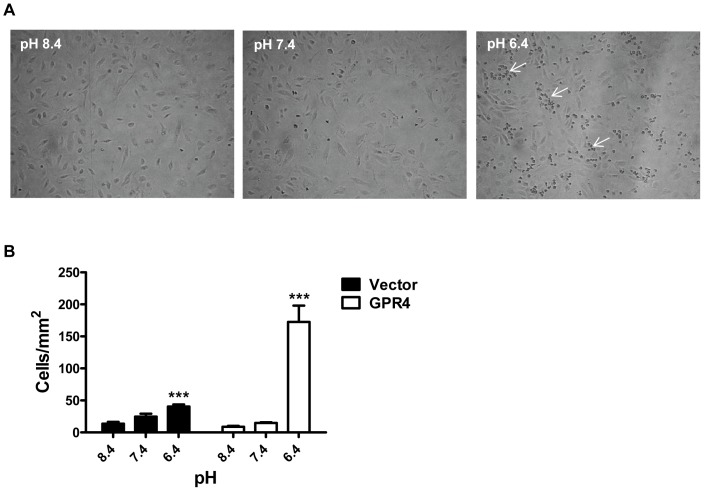
Increased binding of U937 monocytes to vascular endothelial cells treated with acidic pH.(A) U937 monocytic cells were adherent to acidic pH-treated HUVEC/GPR4 cells under a flow condition. Representative pictures are shown with the adhered U937 cells indicated by arrows. (B) HUVECs stably overexpressing GPR4 or control vector were grown to a monolayer, and were treated with EGM-2/HEM pH 8.4, 7.4 or 6.4 media for 5 h. U937 monocytes were adhered to the pH-treated HUVEC monolayer under a flow condition (0.5 dyne/cm2). Error bars indicate the mean ± SEM. ***, P<0.001; compared with the pH 8.4 groups. The results represent the average of cell counts from 6 fields.